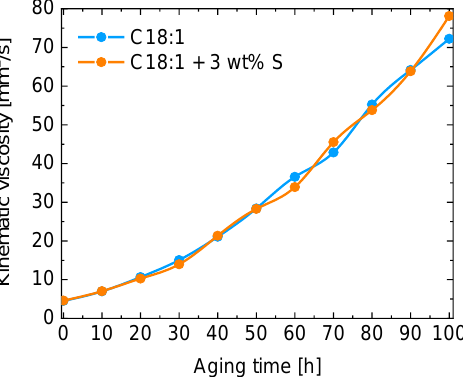
Figure 6. Determination of kinematic viscosity (40 °C) progress over time (0–100 h). The viscosity is compared between C18:1 (blue line) and C18:1 + 3 wt% S (orange line) ( n = 2).